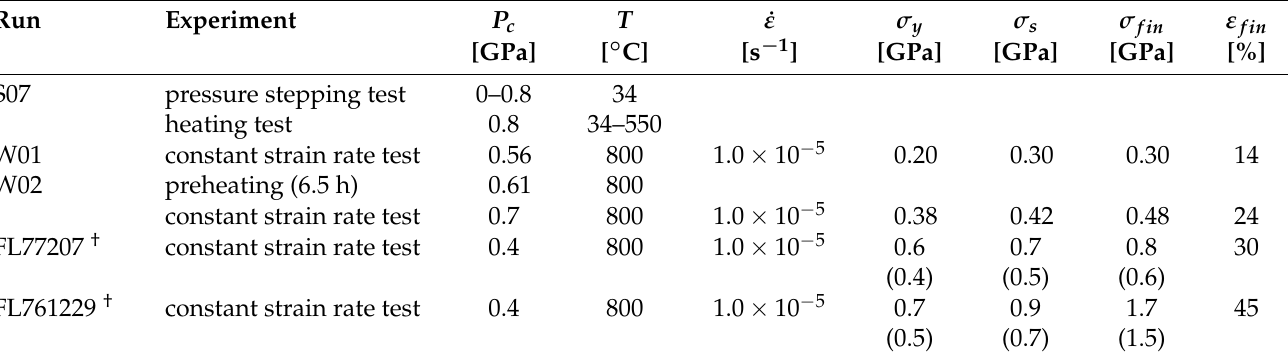
Table 1. Summary of experimental runs. σ y : yield stress. σ s : differential stress at 10% strain. σ fin : final differential stress. ε fin : final strain. † Masuda and Fujimura [4]. Stresses within parentheses are friction-corrected